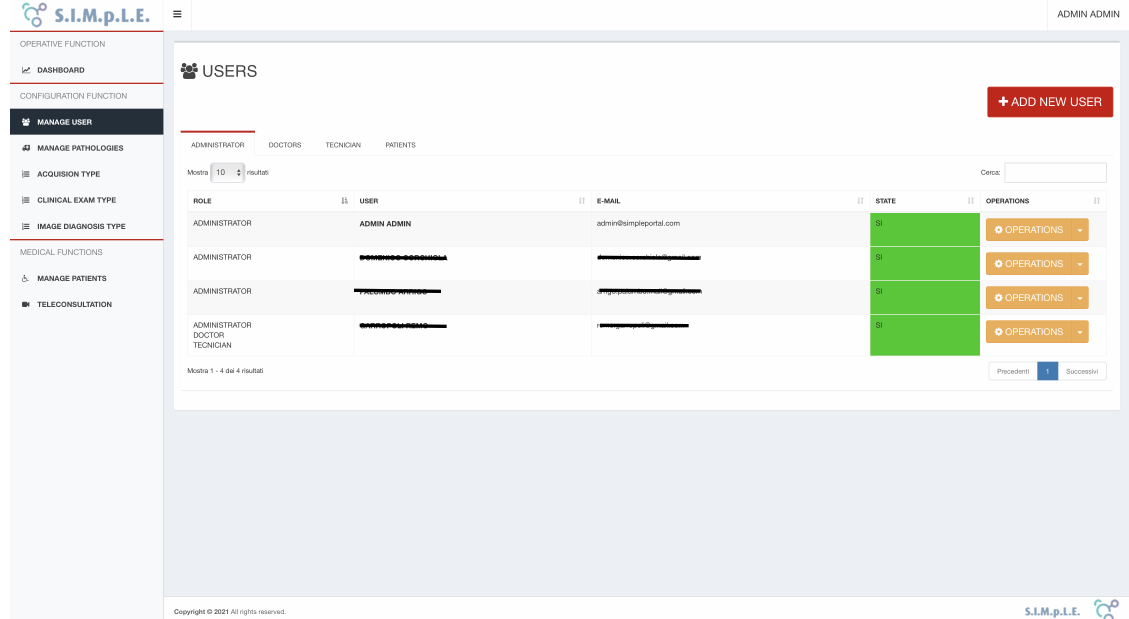
Figure 8. Example of the functionality of viewing, inserting, modifying and deleting users. Users can be Administrators, Doctors, Technicians and Patients and are always managed from the same